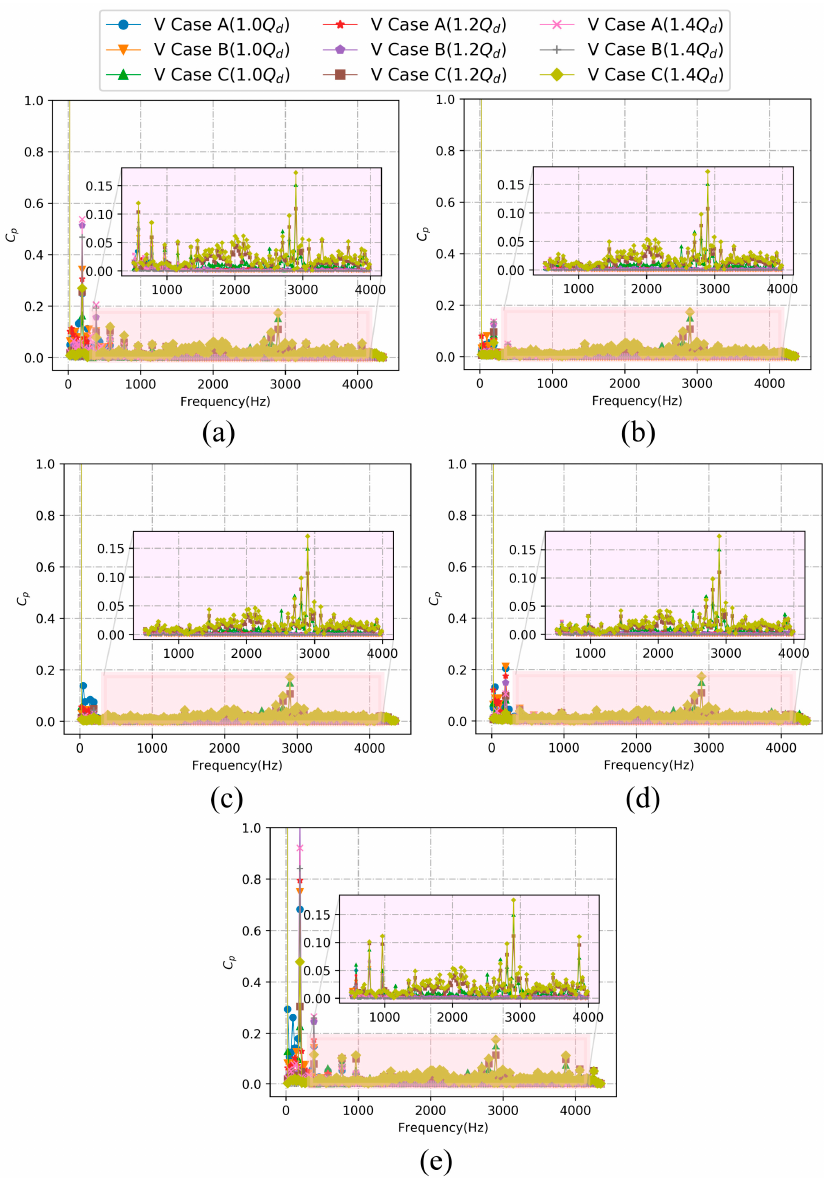
Figure 19. Frequency domain history of pressure fluctuation in volute flow passage at the locations of: ( a ) V1, ( b ) V2, ( c ) V3, ( d ) V4 and ( e ) V5.